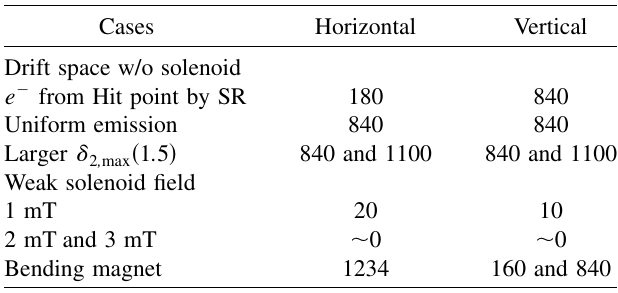
TABLE III. Simulated unstable modes, where (cid:1) the secondary emission rate. All the simulations except the larger